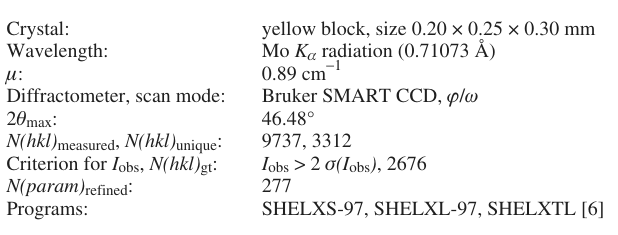
Table 1. Data collection and handling.